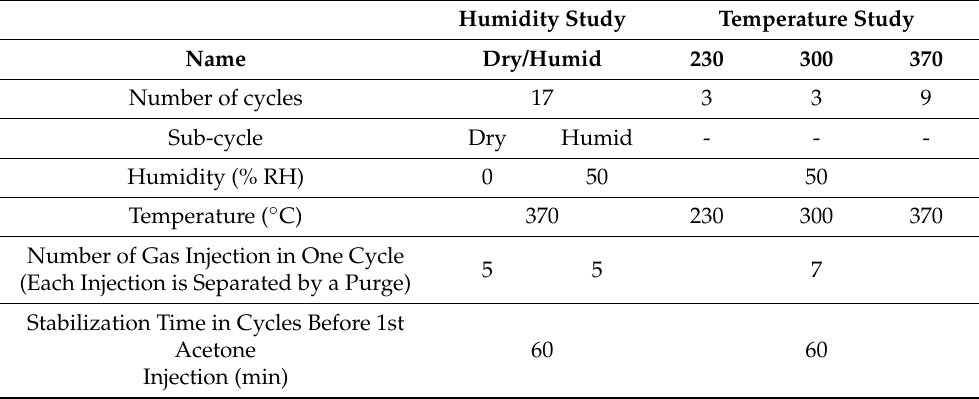
Table 4. Test sequence parameters for Humidity and Temperature Studies. For clarity purpose, the gas sequences (nature, concentration, number of injections, exposure time and purge time) are detailed in Table